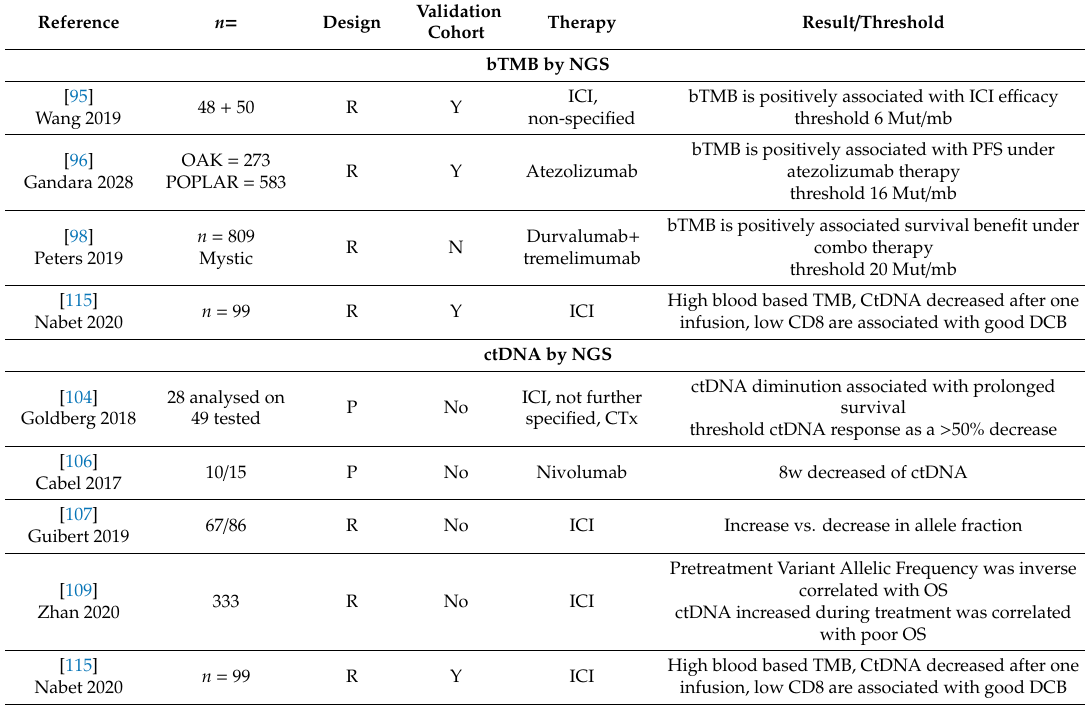
Table 1. Main studies using circulating biomarkers in advanced non-small cell lung cancer (NSCLC) to monitor or guide immune checkpoint inhibitors (ICI)